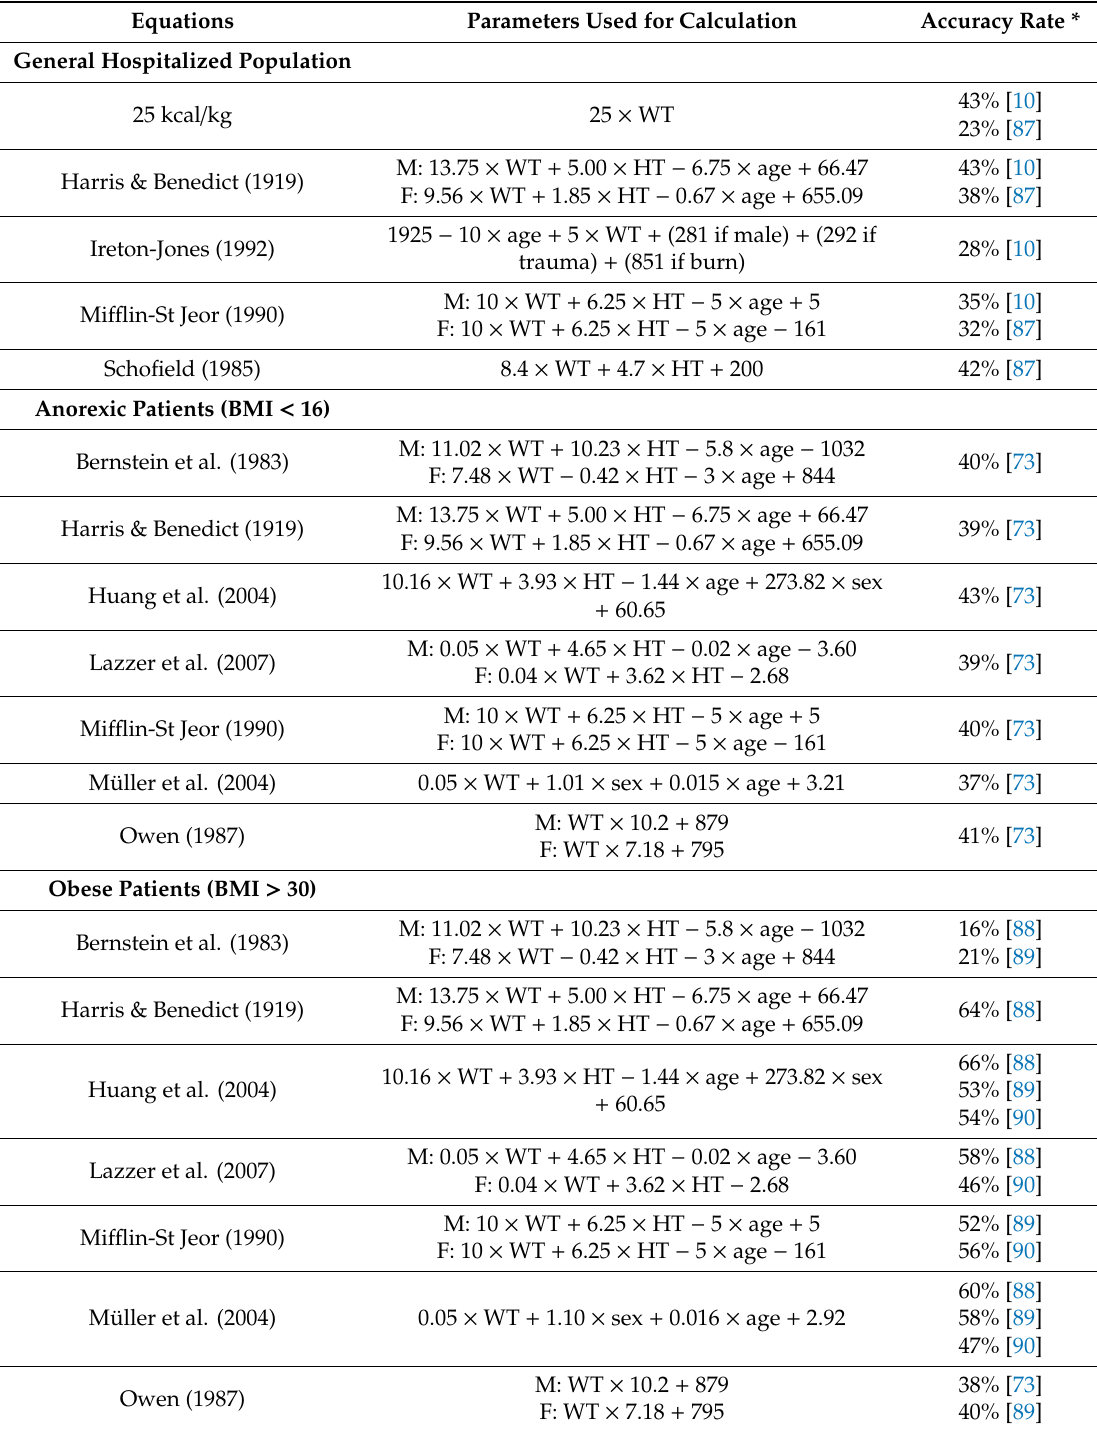
Table 4. Some predictive equations commonly used in clinical practice and tested among di ff erent hospitalized patients against